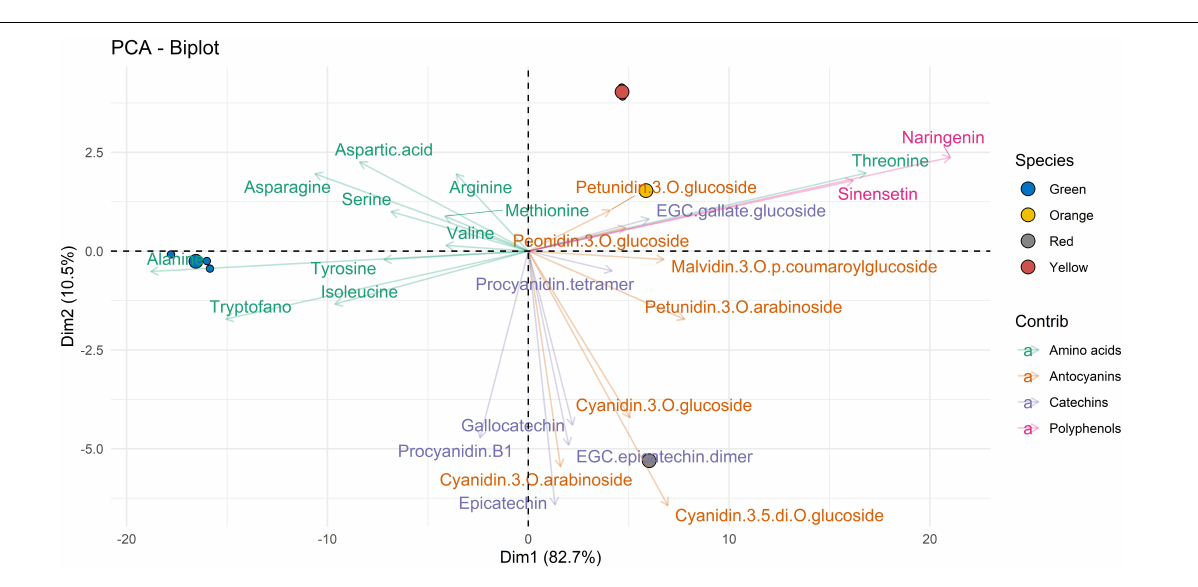
FIGURE 5 | Two-dimensional principal component analysis (PCA) biplot showing associations between experimental samples ( A. unedo fruit) and compounds abundance (clr-transformed data). Original data are summarized in Table 6 and in Supplementary Table 1 . Compounds extracted in E7 are represented. Samples are shown according to the ripening stages (green, yellow, orange, and red) and compounds are shown according to polyphenol